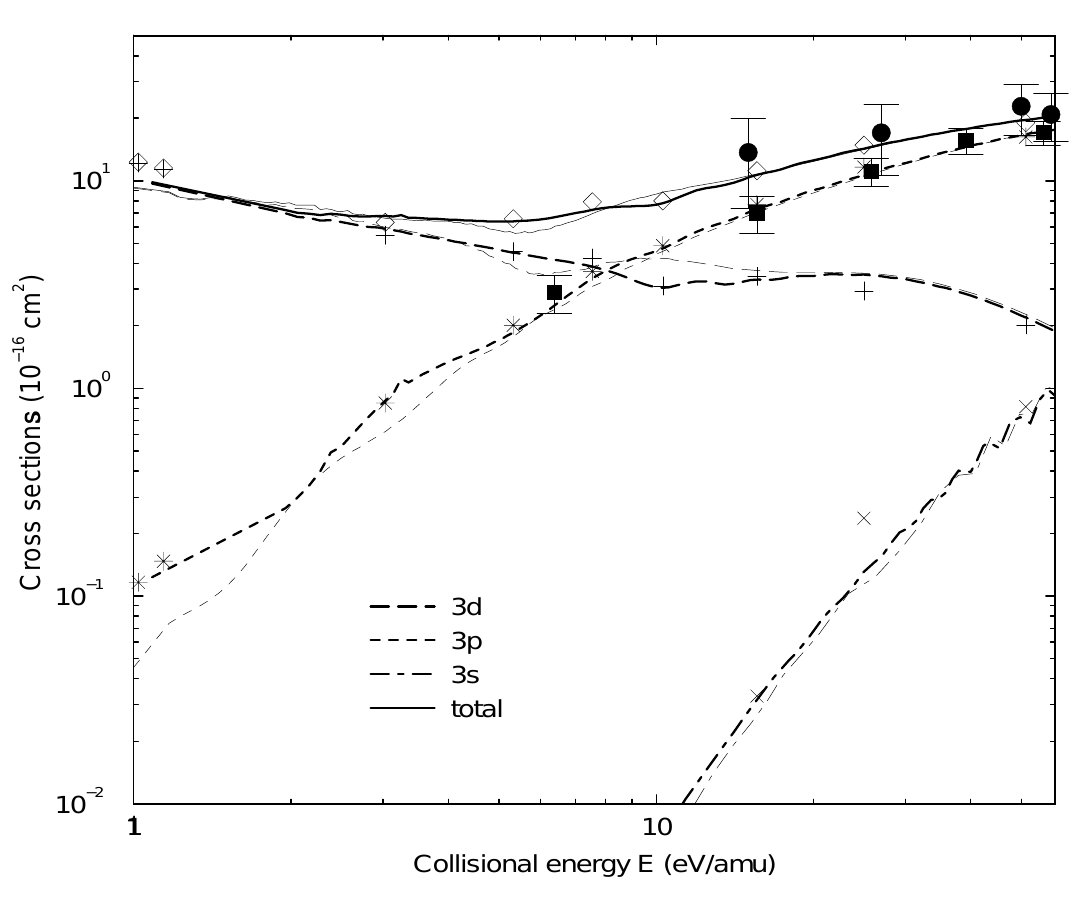
Figure 4: The partial (dashed and dot-dashed curves) and the total (solid curves) cross sections for the charge exchange processes in H + C 4+ (thick lines) and D + C 4+ (thin lines) collisions calculated in the present work. The plusses, the stars, the crosses, and the diamonds are the wave packet data [30] for the partial (3 d , 3 p , and 3 s ) and the total cross sections, respectively. The circles are experimental data for the total cross section in H + C 4+ collisions [39], while the squares are the experimental total cross section in D + C 4+ collisions